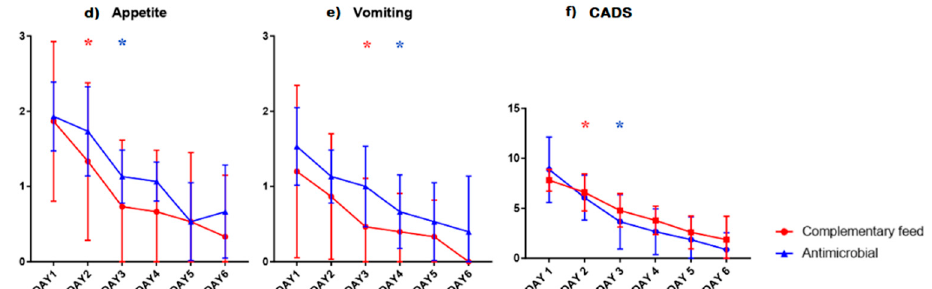
Figure 1. Mean values (y axes) for the parameters ( a ) stool frequency, ( b ) stool consistency, ( c ) general activity, ( d ) appetite, ( e ) vomiting and ( f ) CADS in the groups of dogs treated with complementary feed (group A; red) and antimicrobials (group B; blue). * Day on which the mean significantly decreased compared to day one for each group; color indicates group ( p < 0.05). # Difference between treatments at any point in time ( p < 0.05).